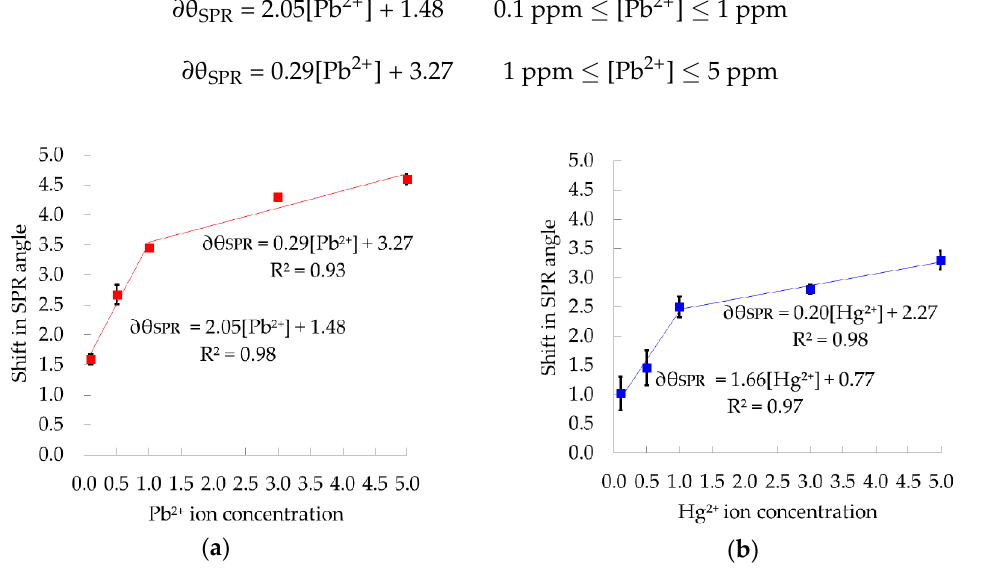
Figure 6. Calibration curve of the Au/Ag/Au/CS–GO SPR sensor in ( a ) Pb 2+ and ( b ) Hg 2+